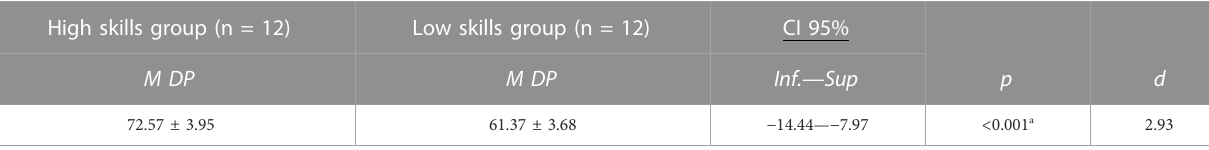
TABLE 1 Comparison of decision-making values between the high skills and low skills groups. High skills group (n =